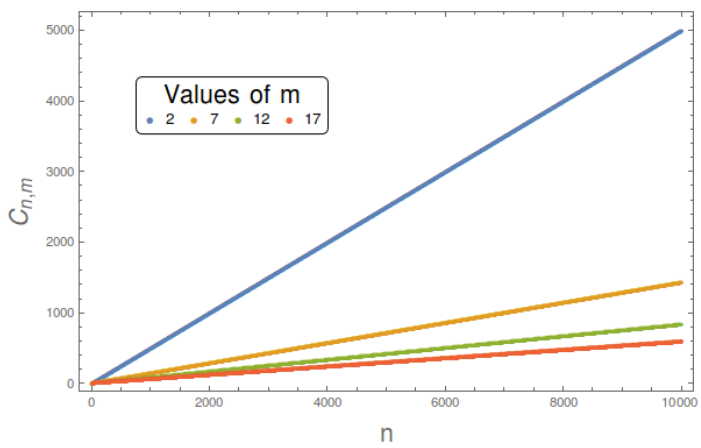
Figure 6. Topological complexity C n;m of torus knot states as a function of n for di(cid:11)erent values of m .